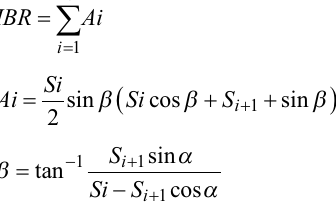
Figure 1 . The most temperature-sensitive species were A. tenuis , E. lamellosa , and both morphotypes of M. capricornis (hereinafter defined as thermosensitive), which displayed 100% mortality after 60 days at 32 ° C, independently of predation conditions ( Table 1 ). The effects of temperature alone were also seen in the remaining species G. fascicularis , P. contigua , and T. reniformis , which were able to withstand the 32 ° C treatment (hereinafter defined as thermotolerant); however, P. contigua displayed 30% mortality and G. fascicularis showed 50% bleaching (in undamaged, non-wounded corals), besides increased paleness. Even though all species tolerated 60 days at 30 ° C, M. capricornis BM, T. reniformis , and P. contigua also displayed increased paleness at this temperature ( Table 1 ). Changes in coral condition upon predation at control temperature occurred only in